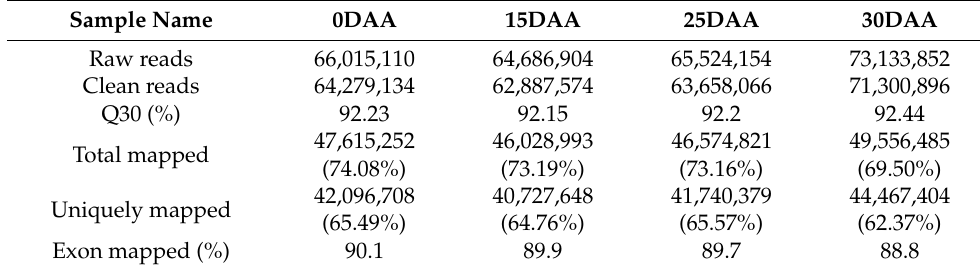
Table 1. Summary of transcriptome sequencing